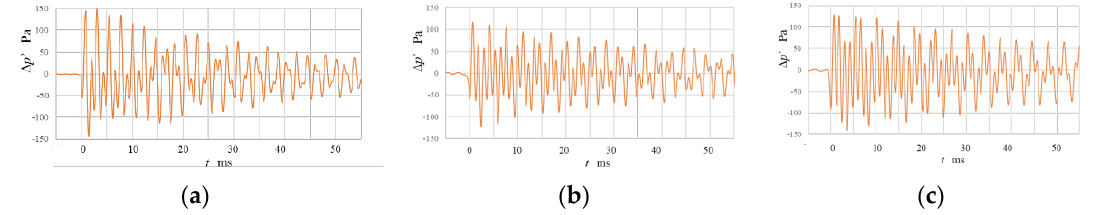
Figure 11. Pressure diagram for the nozzle lengths, L = 10, 20, and 40 mm. ( a ) L = 10 mm. ( b ) L = 20 mm. ( c ) L = 40 mm.